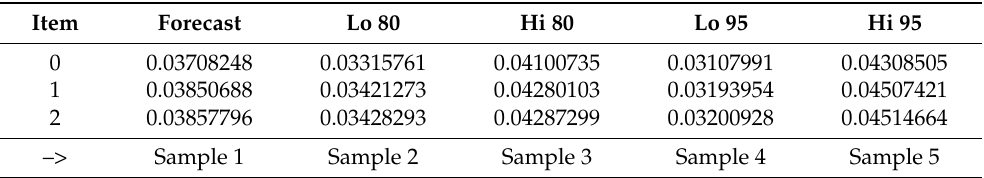
Table 2. Forecast dataset that includes an 80% confidence interval (CI) and 95% CI, both Low and High.